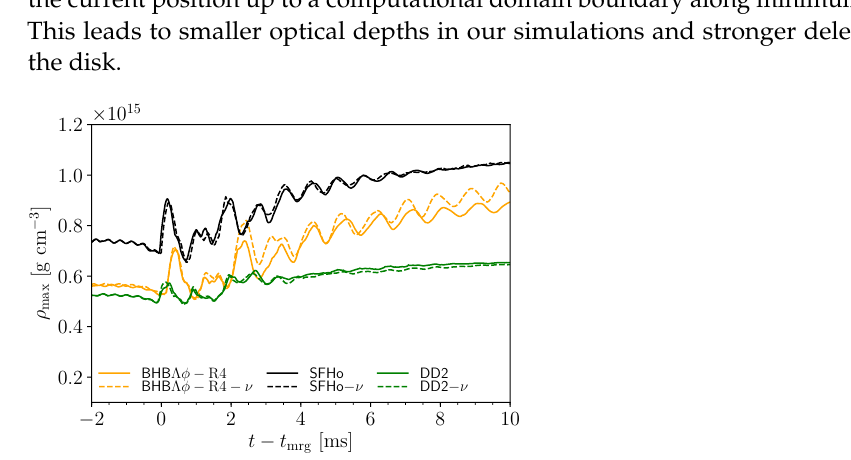
Figure 5. Post-merger evolution of the maximum rest-mass density ρ max reached by the different EoSs considered in this article. Solid lines refer to the runs without NLS, while dashed lines represent the NLS runs. Our results for the SFHo and DD2 cases are in agreement with those reported in [58]. For the BHB Λ φ EoS, we use resolution R4 (see Table 2).